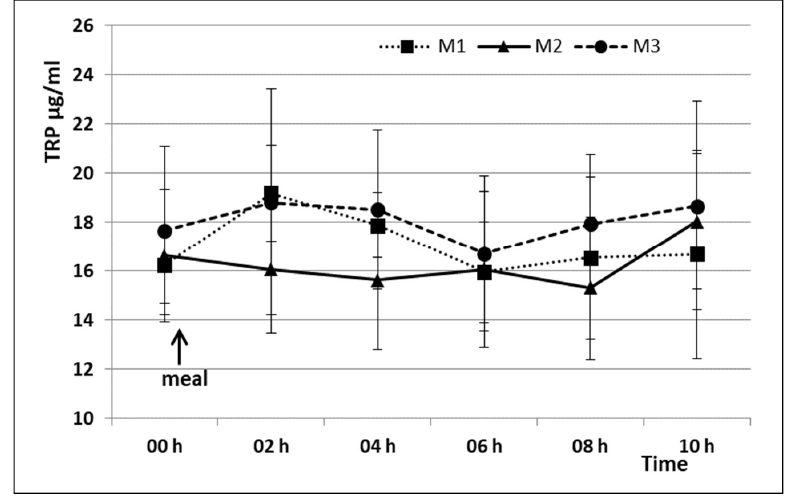
Figure 1. Mean plasmatic TRP concentrations (±S.D.) after three different meals. M1 = Meal 1; M2 = Meal 2; M3 = Meal 3.